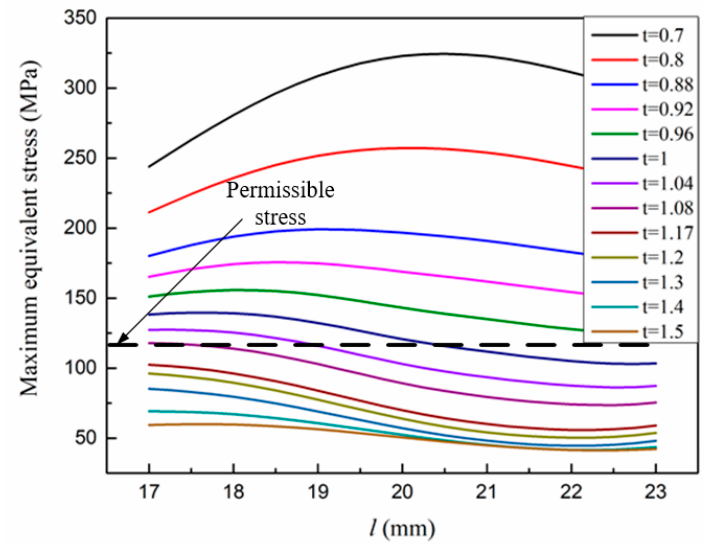
Figure 7. Maximum equivalent stress structural parameters versus. Under the selected size parameters, the input/output validation of the structure was carried out, and the results are shown in Figure 8.